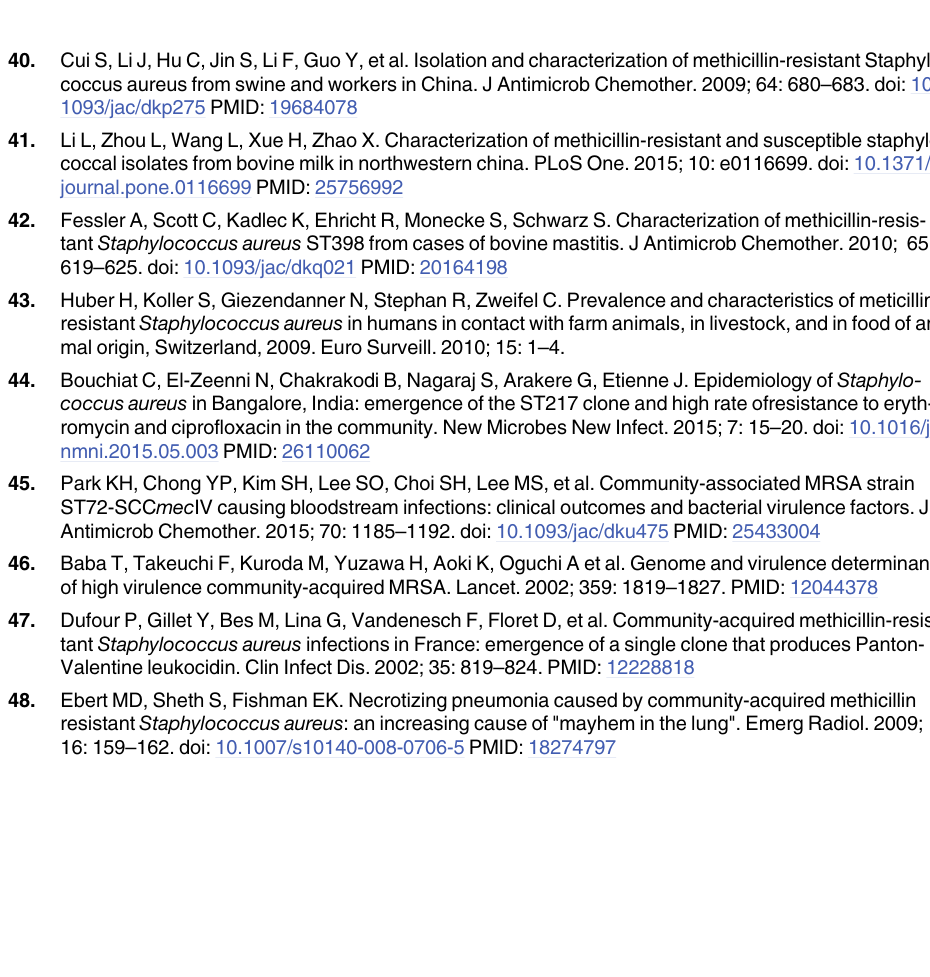
PLOS ONE | DOI:10.1371/journal.pone.0162256 September 7,